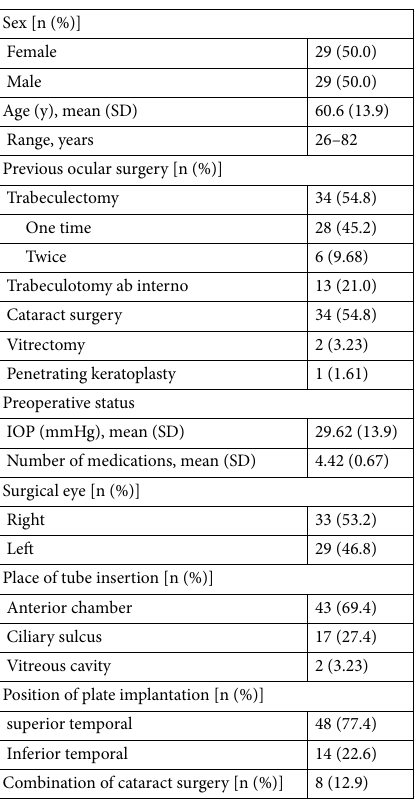
Table 1. Demographic data and glaucoma baseline status in 62 eyes of 58 patients. SD, standard deviation; IOP, intraocular